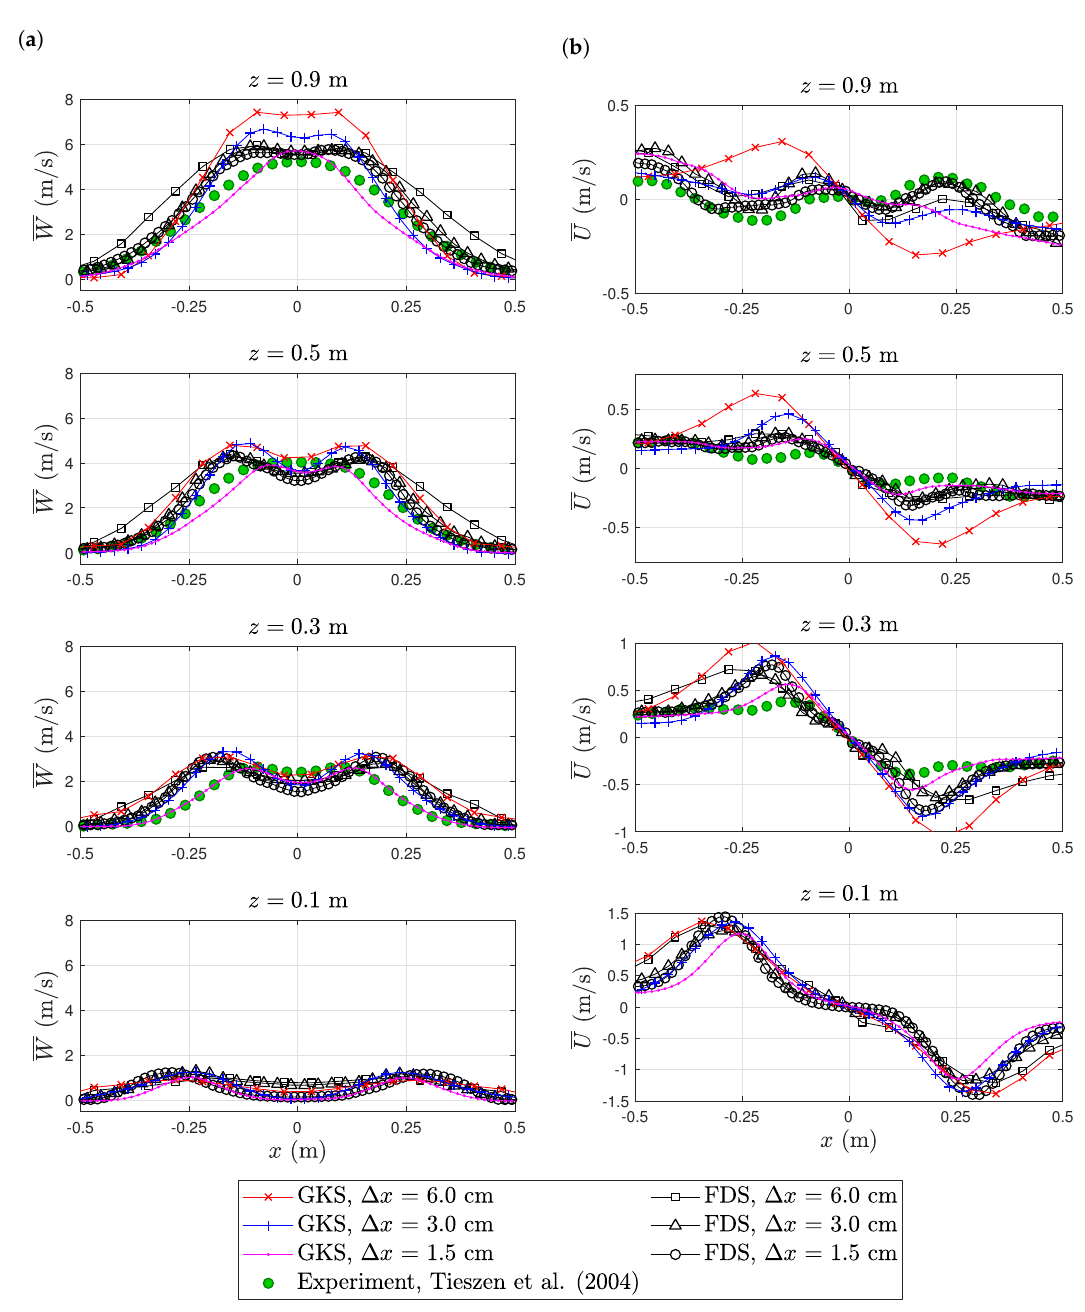
Figure 12. Sandia flame, Test 24: profiles of axial (vertical) velocity ( a ) and radial(horizontal) velocity ( b ). The experimental data are available online at https://github.com/firemodels/exp/tree/master/